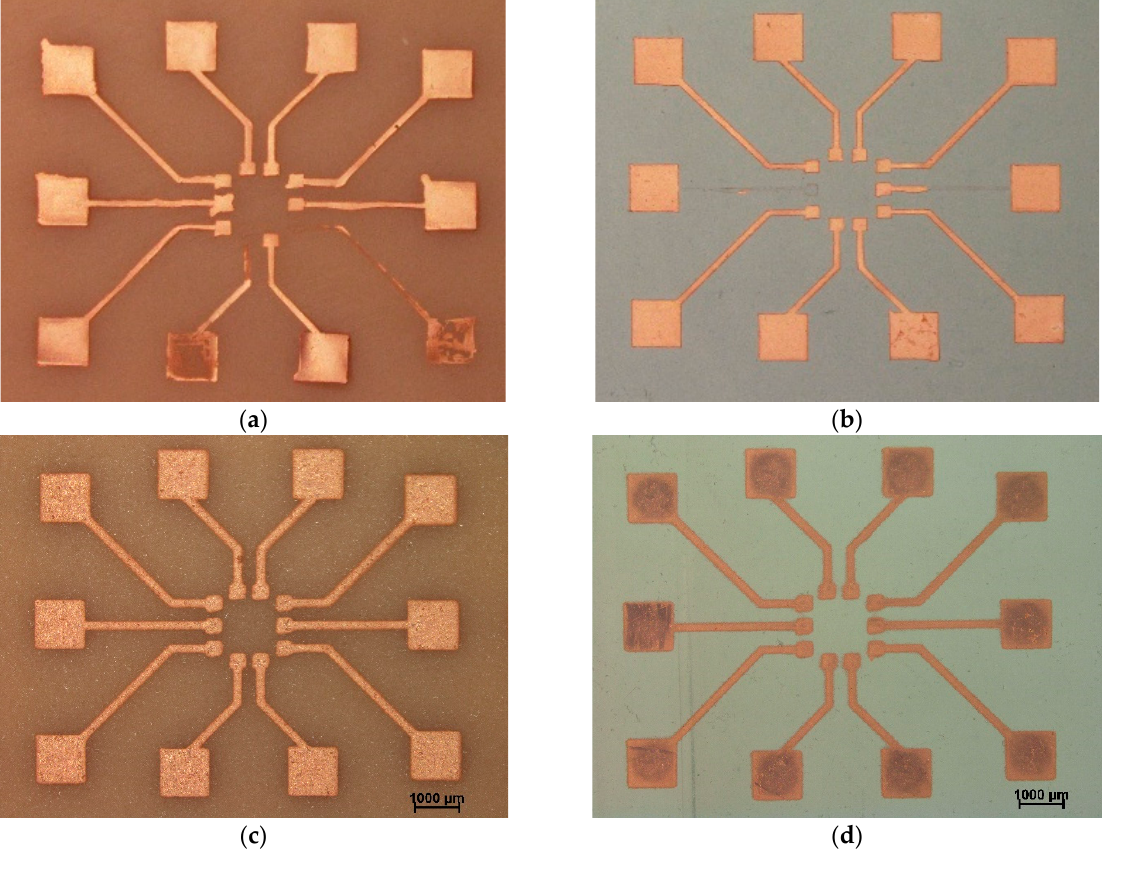
Figure 5. Electroless copper plating on printed silver tracks (ink: Sicrys I30 EG-1) on 2D test substrates with 60min plating time on Dreve FotoTec DLP-A ( a ) and on Luxaprint 3D mold ( b ) and with 15min plating time on Dreve FotoTec DLP-A ( c ) and on Luxaprint 3D mold ( d ).